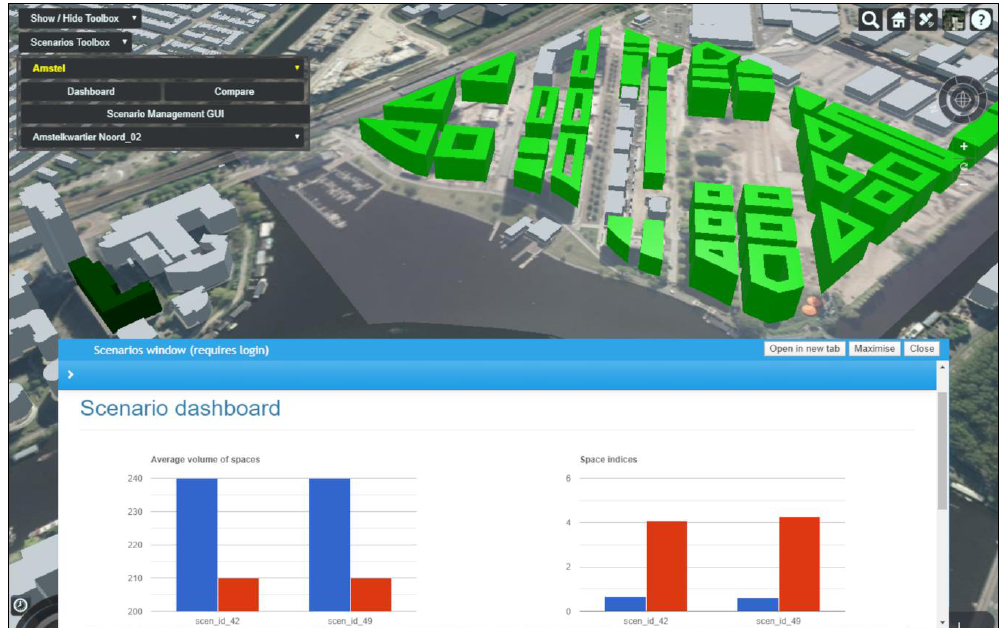
Figure 9. Examples of the online data exploration via the Scenario dashboard.